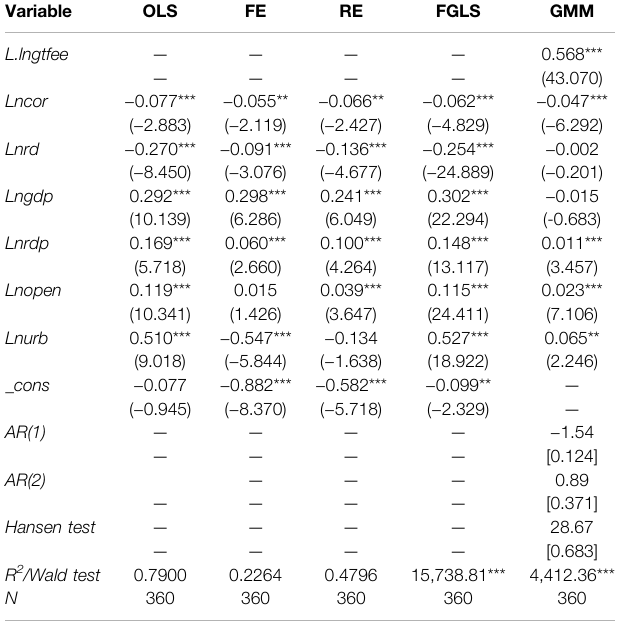
TABLE 2 | The results of corruption on